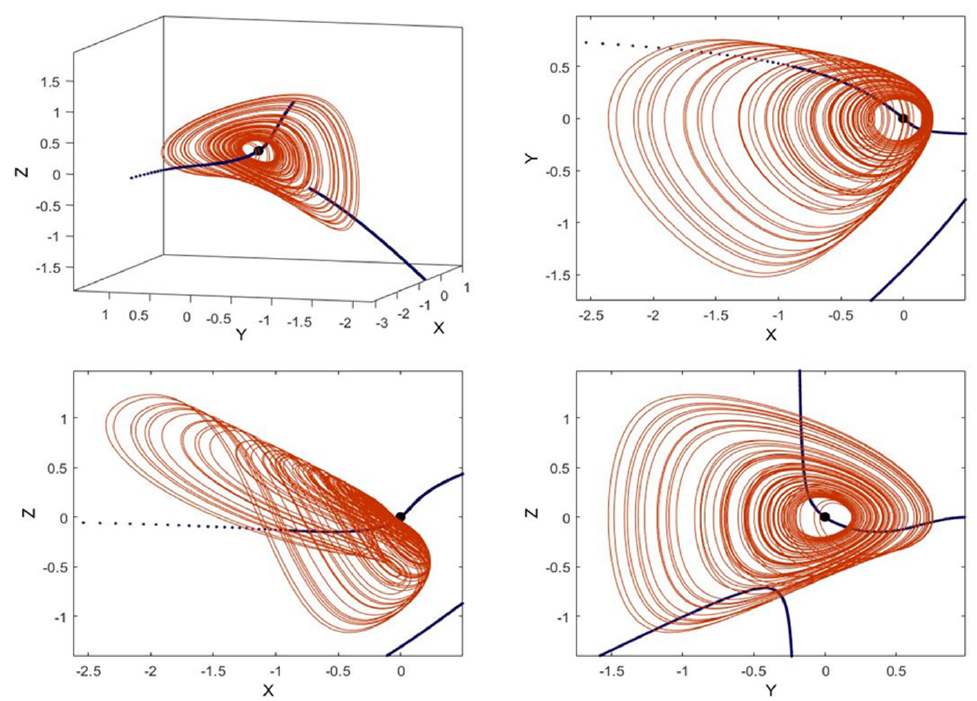
Figure 5. Connecting curves of System (1) in k = 0. It is observed that the connecting curves are skeleton − like curves around which the flow evolves. Additionally, it is obtained that the curve passes through the fixed point.